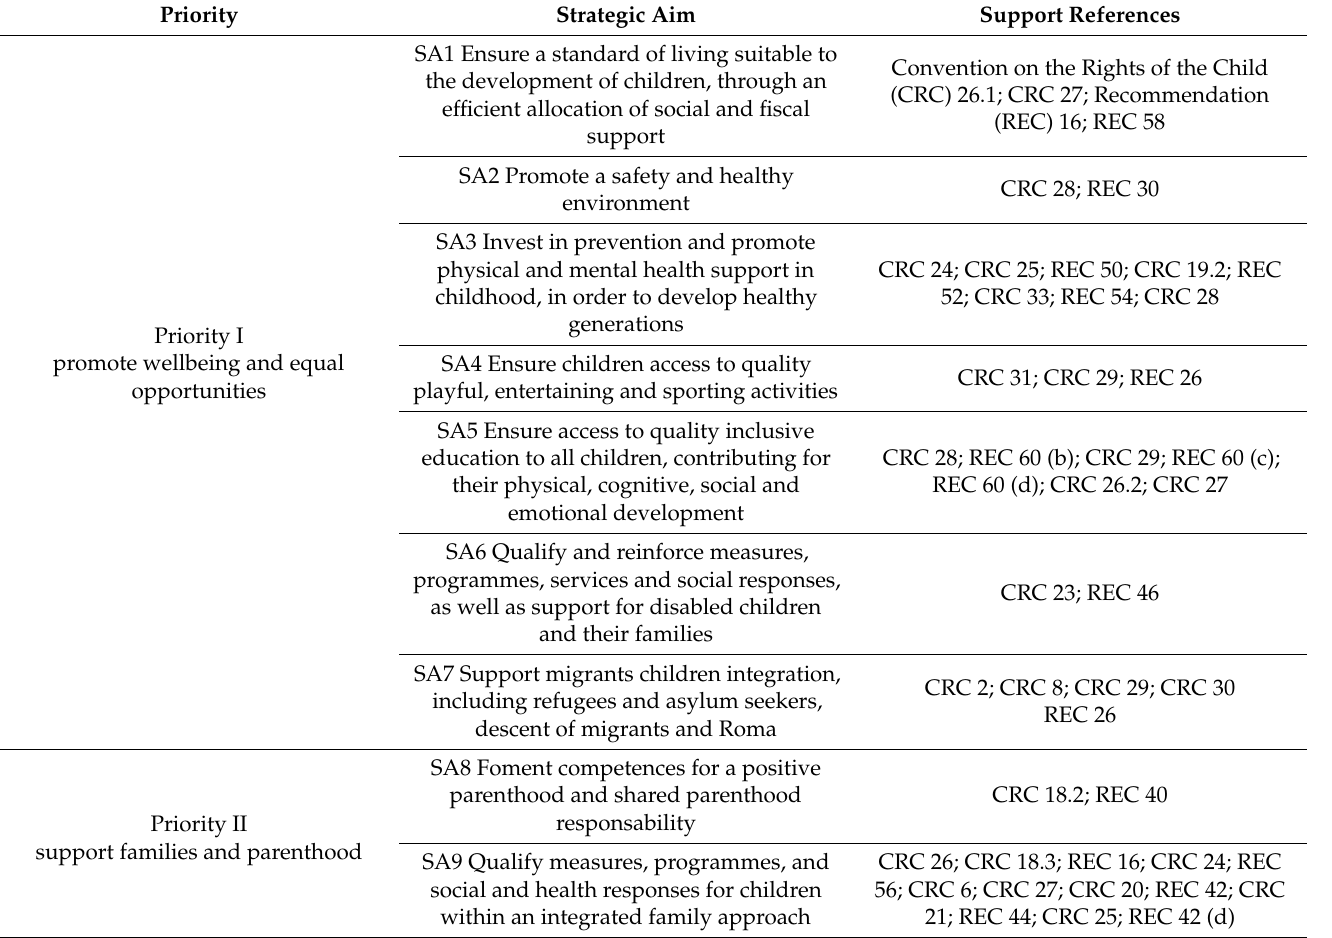
Table A1. Portuguese National Strategy for the Rights of the Child’s